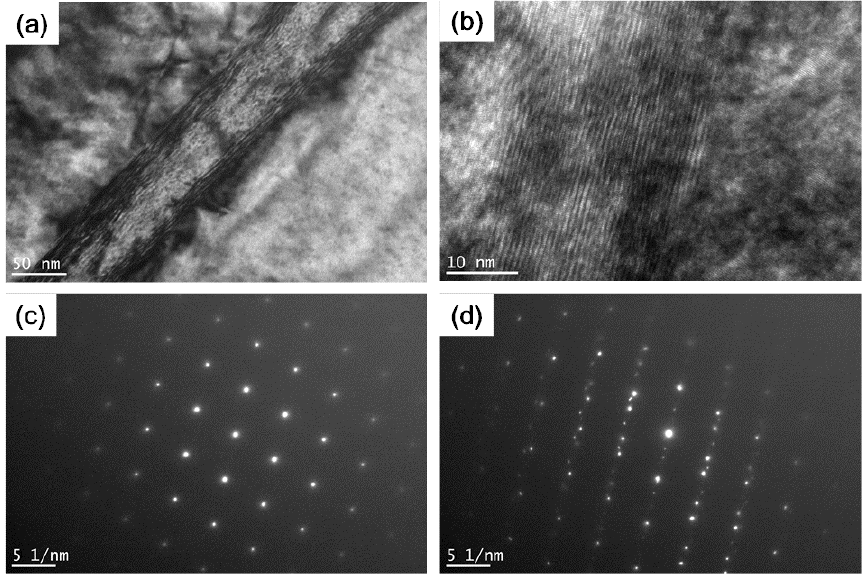
Figure 5. Transmission electron microscopy (TEM) and selected area electron diffraction (SAED) patterns of Ti-10In alloy. ( a ) TEM image, ( b ) magnified TEM image, and ( c , d ) representative SAED